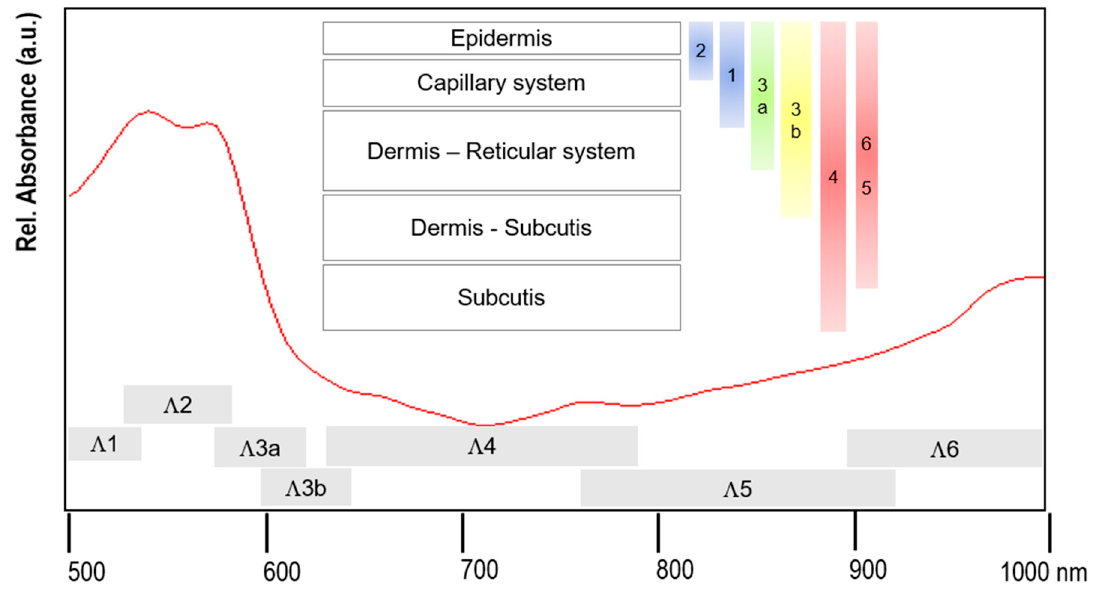
Figure 9. Remission spectrum represented in the “absorbance“ mode. Spectral segments Λ i and schematic: skin layers and approximate measuring depth in the spectral segments.